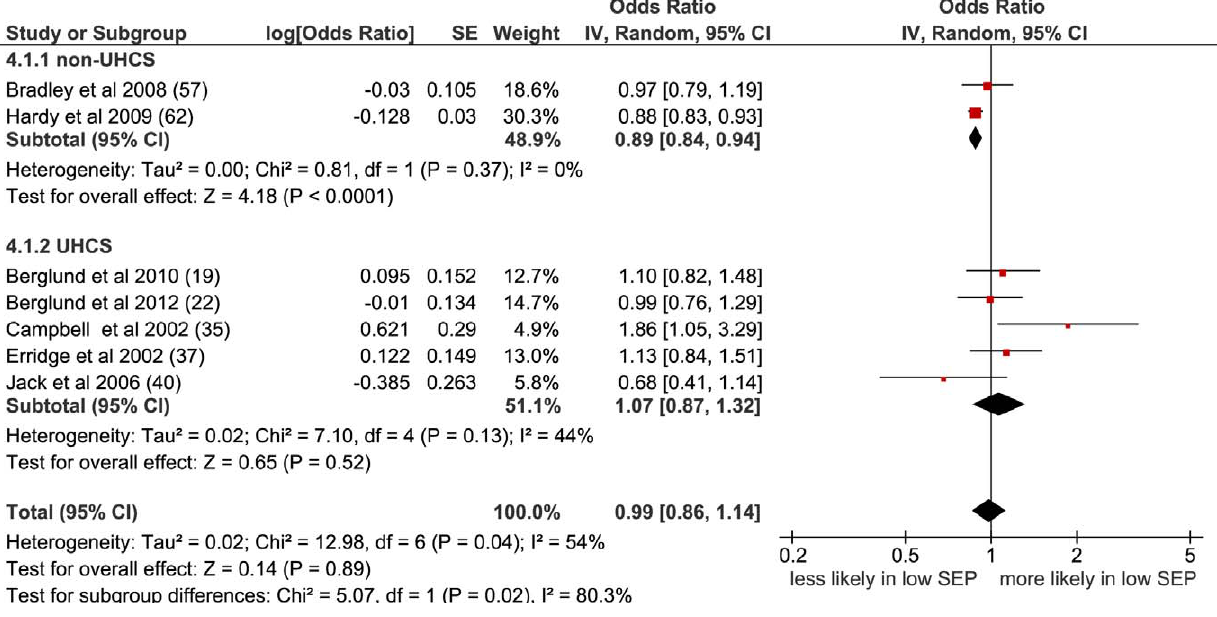
Figure 4. Meta-analysis of odds of receipt of radiotherapy in low versus high SEP. CI, confidence interval; non-UHCS, non-universal health care system; OR, odds ratio; SE, standard error; SEP, socioeconomic position; UHCS, universal health care system.